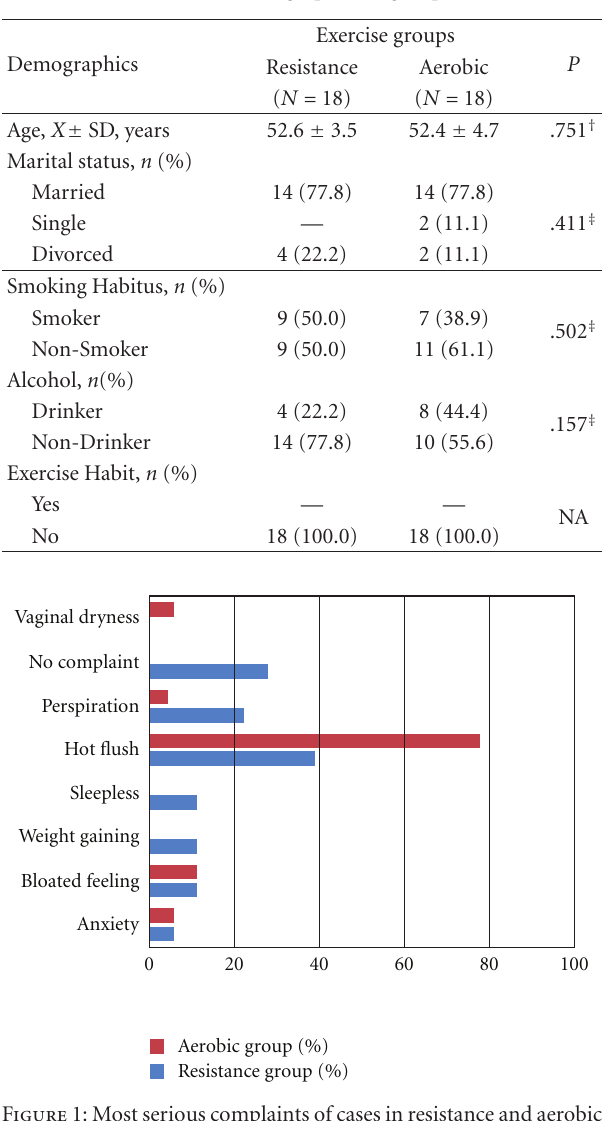
Table 1: Demographics of groups.